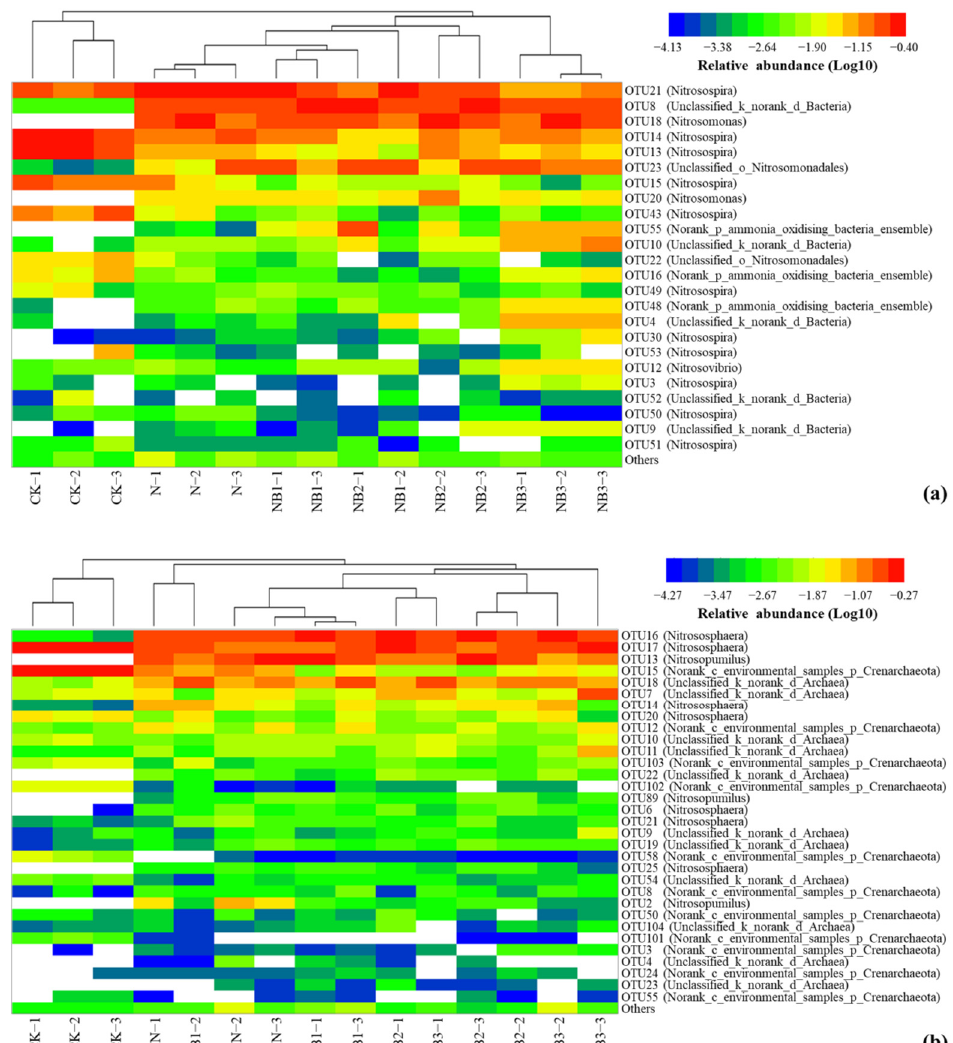
Figure 2. Heat maps showing taxa frequency distribution of OTUs for AOB ( a ) and AOA ( b ) at the genus level, plus the cluster structure across all the treatments.